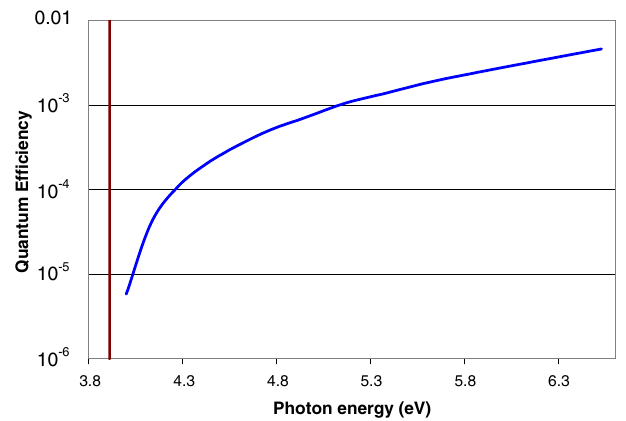
FIG. 4. (Color) Predicted QE for a lead photocathode as a function of incident photon energy. The vertical line represents the expected work function accounting for the Schottky effect (3.91